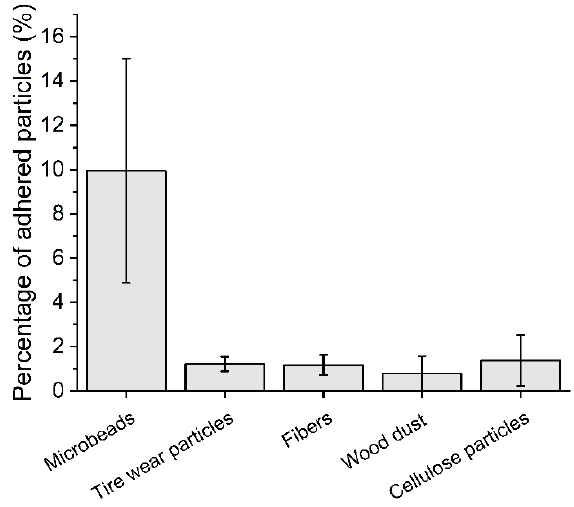
Figure 2. The percentage of adhered microplastics and natural particles to duckweed.